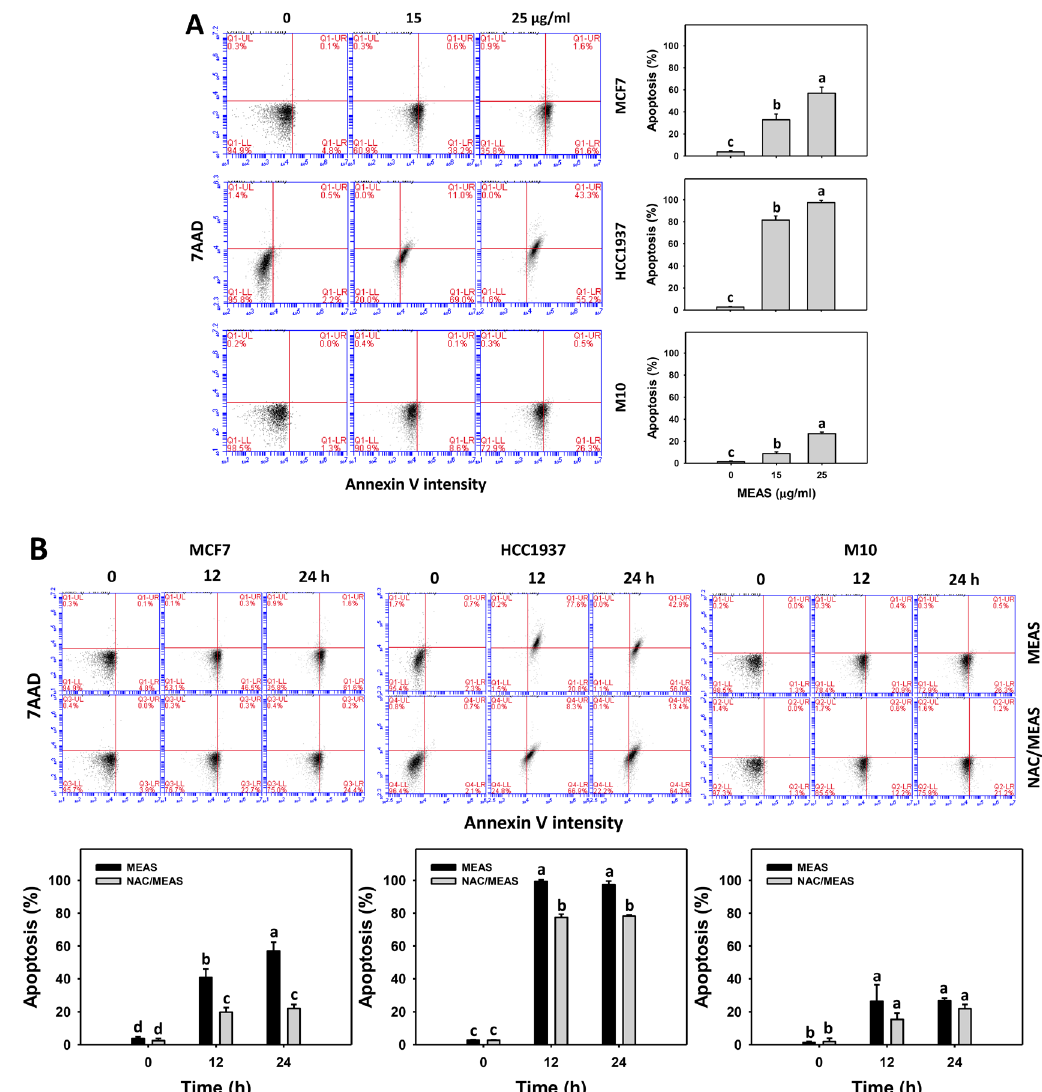
Figure 4. MEAS increased the annexin V intensity of breast cancer cells. ( A ) Annexin V-apoptosis assay of MEAS. Except for normal breast cells (M10), others were TNBC and non-TNBC cells. Flow cytometry was performed after 24 h drug treatment. Annexin V (+) (%), such as annexin V (+)/7AAD (+, − ), accounts for apoptosis (%). ( B ) Annexin V-apoptosis assay of NAC/MEAS. NAC/MEAS represents NAC pretreatment (10 mM, 1 h) and MEAS posttreatment for 0, 12, and 24 h. Data = mean ± SD ( n = 3). Statistical software assigned low-case letters to each treatment.